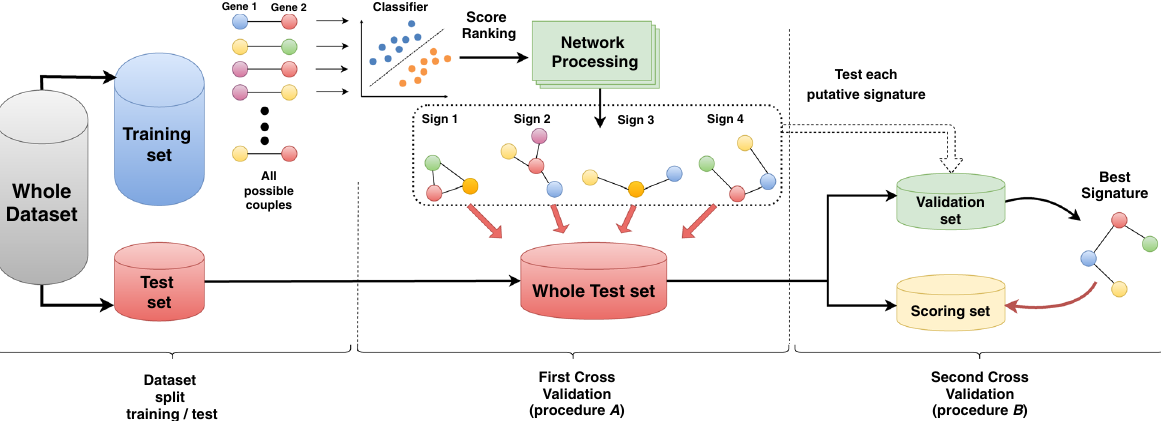
Figure 2. Scheme of the DNetPRO algorithm. On the “Training set”, all possible pairs of features are used for Discriminant Analysis, generating a fully connected network with links weighted by pair classification performances. By thresholding the weighted links (i.e., setting to zero links with performance below a defined threshold) one or more signatures are identified as the resulting network connected components. In procedure A , signatures’ performance ars evaluated on the “Whole Test set”. In procedure B , a unique best signature is identified on a “Validation set” and then tested in a “Scoring set”, obtained by further splitting the “Whole Test